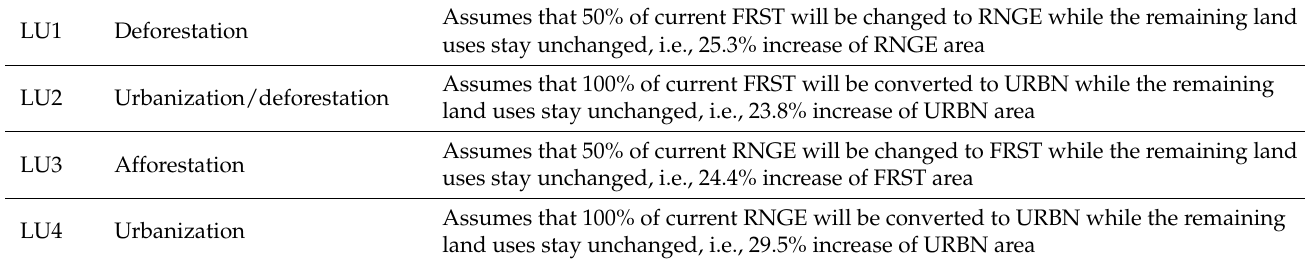
Table 2. The four land use change scenarios based on LU0 (i.e., forest-mixed (50.6%),